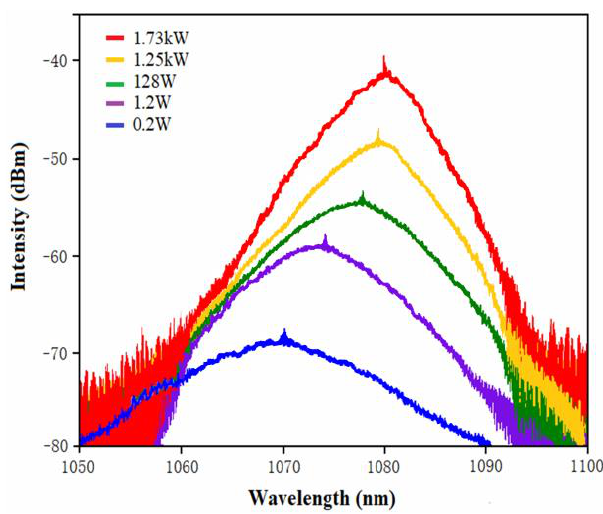
Figure 6. Main spectral line frequency-shift process.